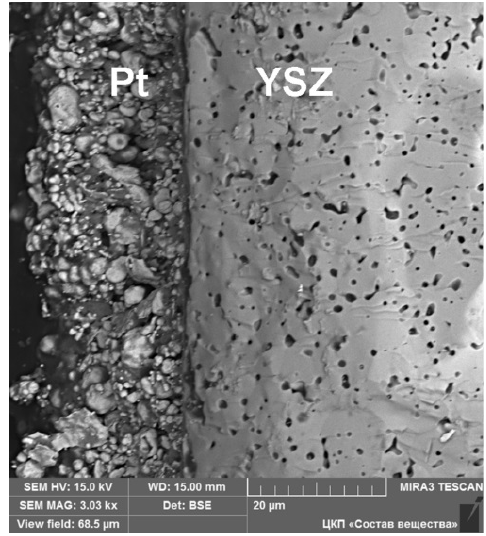
Figure 1. SEM image of a cross section of YSZ/Pt sample.